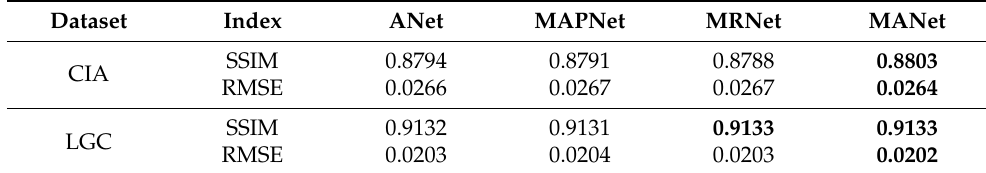
Table 3. The results of comparative